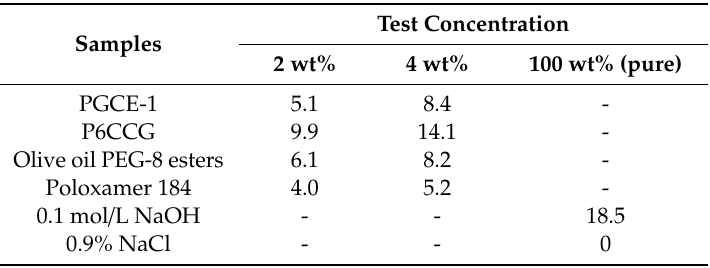
Table 5. Irritation scores of samples evaluated by hen’s egg test-chorioallantoic membrane assay